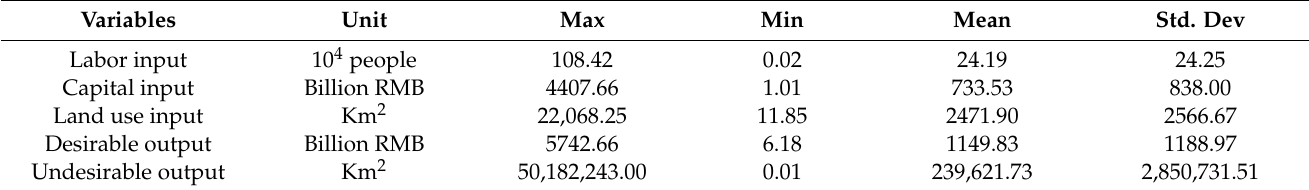
Table 1. Descriptive statistical information of input and output variables